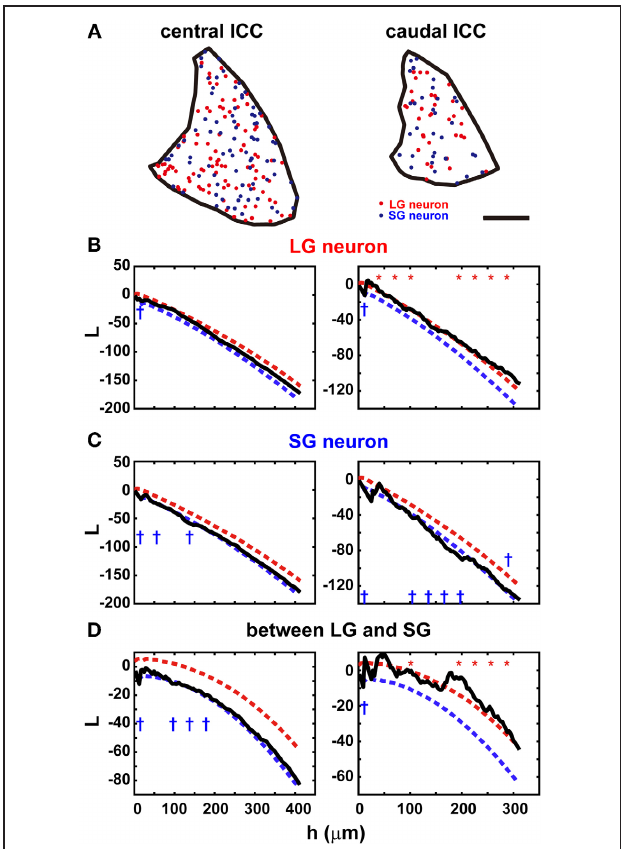
FIGURE 2 | Distribution in the ICC of two classes of GABAergic neurons.(A) Location of the cell bodies of LG neurons (red) and SG neurons (blue) in the ICC (black border). Left: center of the ICC. Right: caudal ICC. Note the sparse and clustered distribution in the caudal ICC. Scale bar: 400 μ m. (B) The L function of LG neurons in the central ICC (left) and caudal ICC (right). Red and blue dotted lines are upper and lower limits of the 95% confidence interval, respectively. In the central ICC, the function falls primarily within the confidence limits, while in the caudal ICC, the function is slightly larger than the confidence interval. At 10 points of h evenly spaced, asterisks and daggers are shown if the function is larger or smaller than the confidence interval, respectively. (C) The L function of SG neurons in the central ICC (left) and caudal ICC (right). In the central ICC, the function falls within the confidence limits in the larger values of h . When h is smaller, the function falls below the confidence limit. In the caudal ICC, the L function is significant for larger values of h . (D) reciprocal L functions for two classes of GABAergic neurons in the central ICC (left) and caudal ICC (right). In the central ICC, the function is significant for only the smaller h . In the caudal ICC, the function is significantly at larger values of h